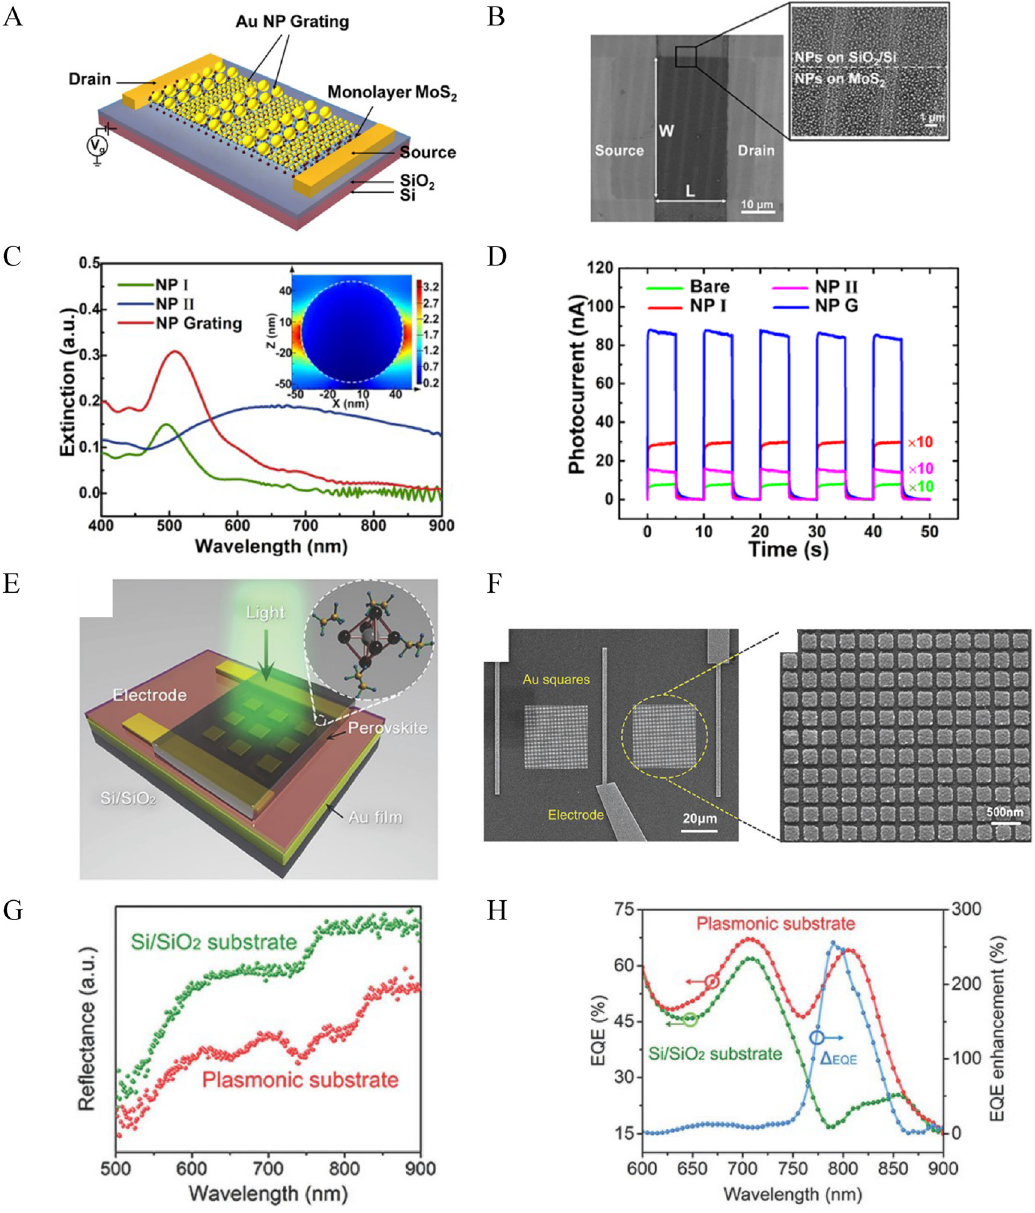
Figure4: (A)Schematicrepresentationand(B)SEMimagesofAunanoparticlegrating/MoS 2 hybridphotodetector.(C)ExtinctionspectraofAu nanoparticles(NPI:diameter/period=47/110nmandNPII:diameter/period=200/600nm)andAunanoparticlegratingwithperiodof4 μ m. Inset: simulated electric fi eld distribution around NP I. (D) Photocurrents of MoS 2 photodetectors with different plasmonic nanostructures [106].Copyright2020,AmericanChemicalSociety.(E)Schematicrepresentationand(F)SEMimagesofperovskitephotodetectoronAusquare arrays. (G) Measured re fl ection spectra of perovskite fi lms on Si/SiO 2 and plasmonic substrates. (H) Spectral external quantum ef fi ciency of the perovskite devices on Si/SiO 2 and plasmonic substrates [107]. Copyright 2018, WILEY-VCH Verlag GmbH & Co. KGaA,